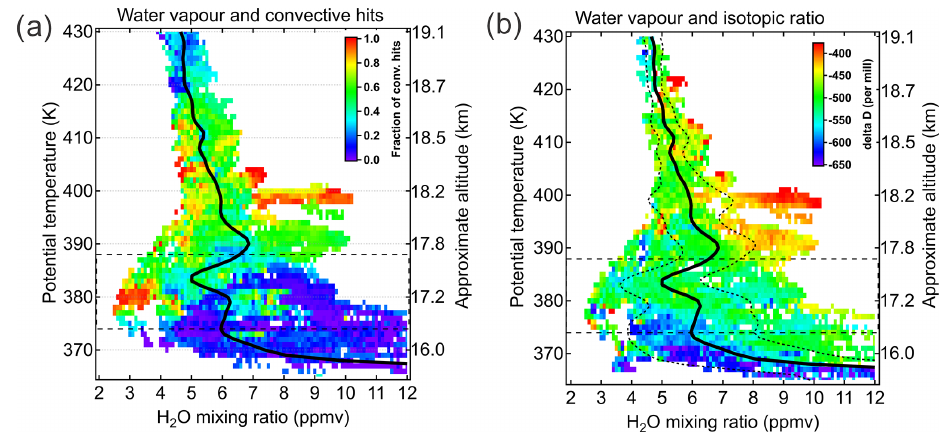
Figure 4. Binned ensemble (bin size 0.1ppmv by 1K) of FLASH H 2 O measurements from all flights except F1 and F5 for which no isotopic data are available. The pixels are colour-coded by (a) convective hits fraction (see text for details) and (b) the ChiWIS HDO / H 2 O isotopic ratio. The black solid and dashed curves depict campaign-median H 2 O profile and 1 standard deviation respectively (all flights). The horizontal dashed lines mark the vertical range of the CPT level encountered during the campaign. Note that the convective origin is specific to both anomalously wet and anomalously dry parcels (a) , whereas the wettest parcels in the lower stratosphere are isotopically enhanced (b)